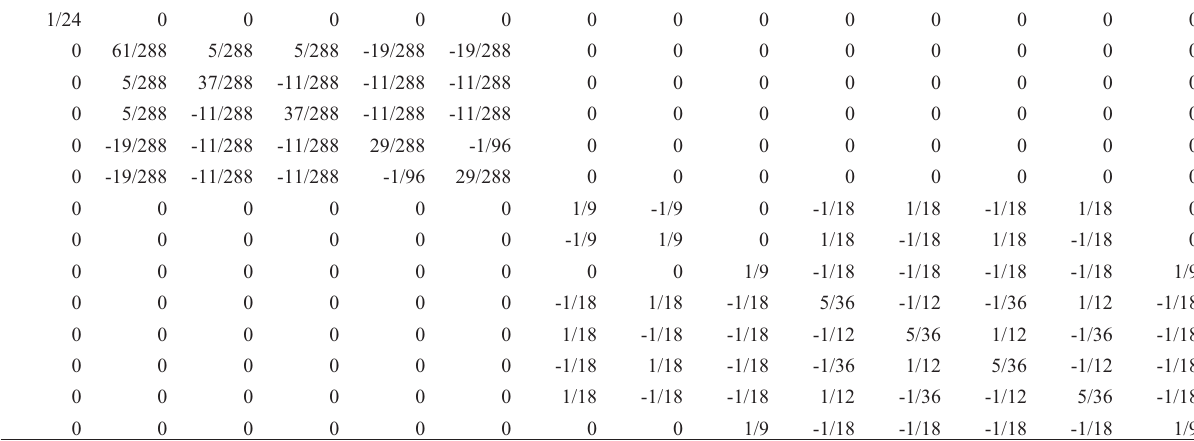
Table 13 - Estimates of the variances and covariances of the effects for an incomplete diallel model (Case 2, type 2 constraints) calculated using a matrix approach.